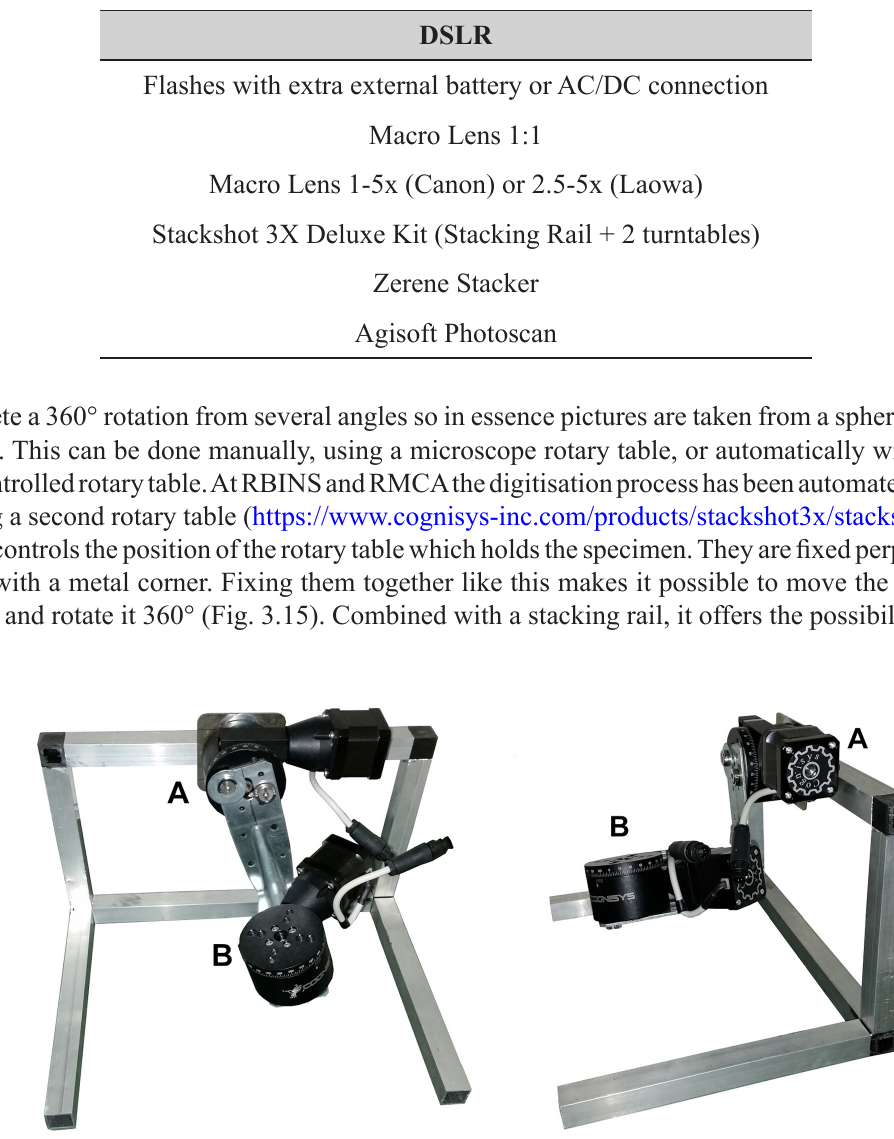
Table 3.2. Equipment list needed to perform photogrammetry of small specimens.